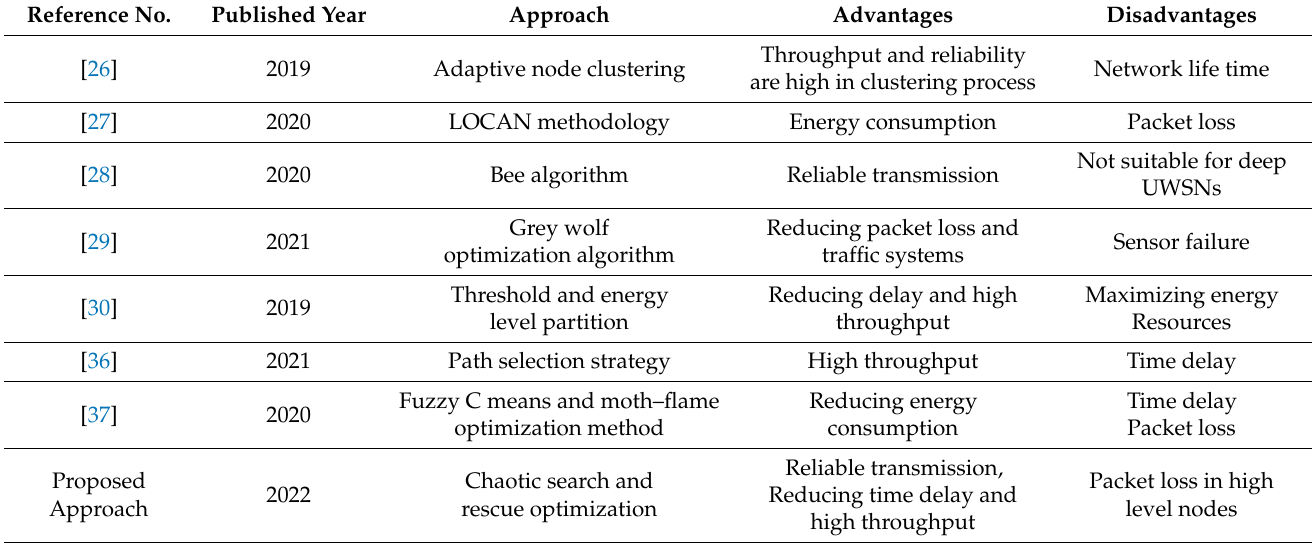
Table 1. Summary of existing